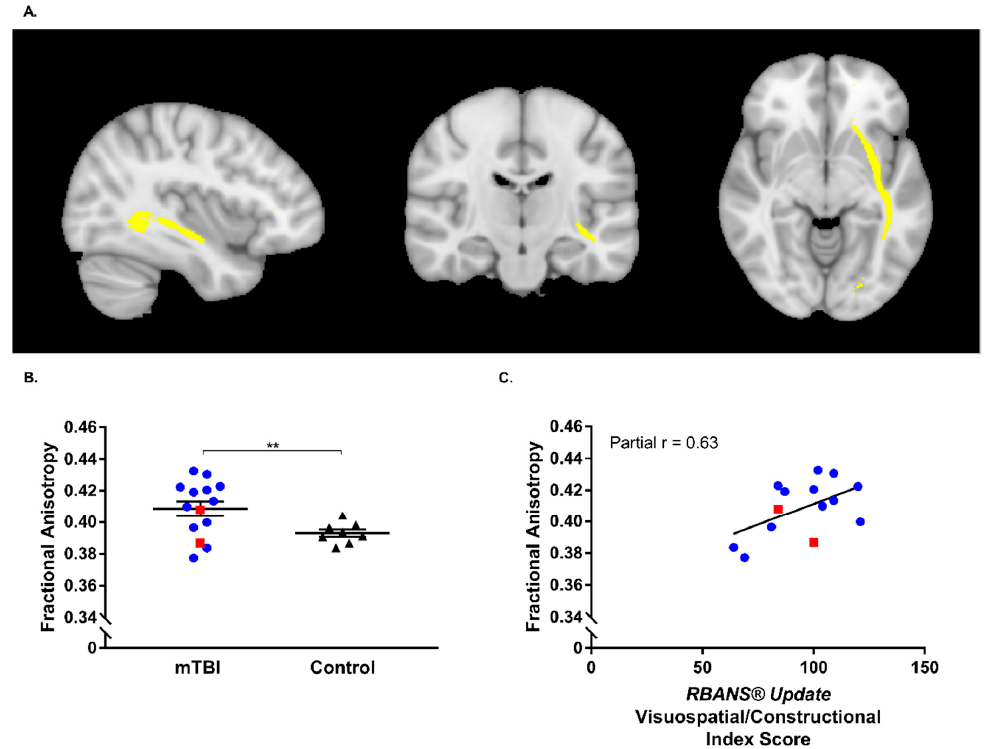
Figure 6. ( A ) Left inferior fronto-occipital fasciculus (IFOF) threshold of 30 presented in radiological view (voxel coordinates 128,108,65); ( B ) Scatterplot depicting fractional anisotropy values